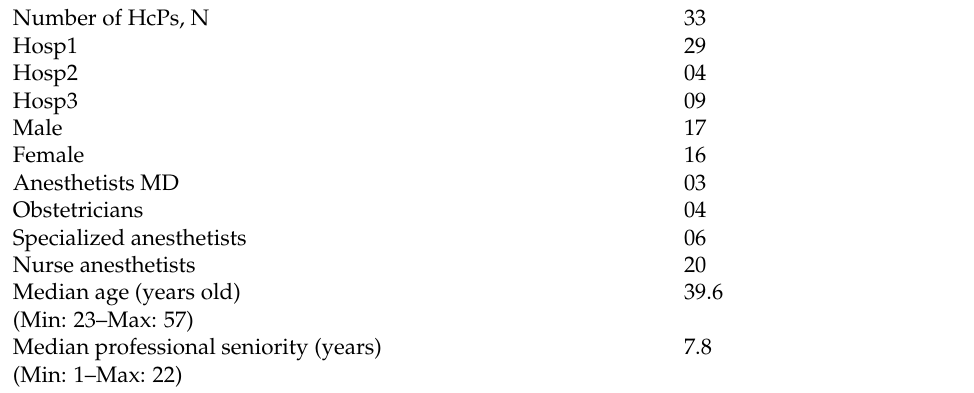
Table 1. Demographic characteristics of HcPs included in the survey.